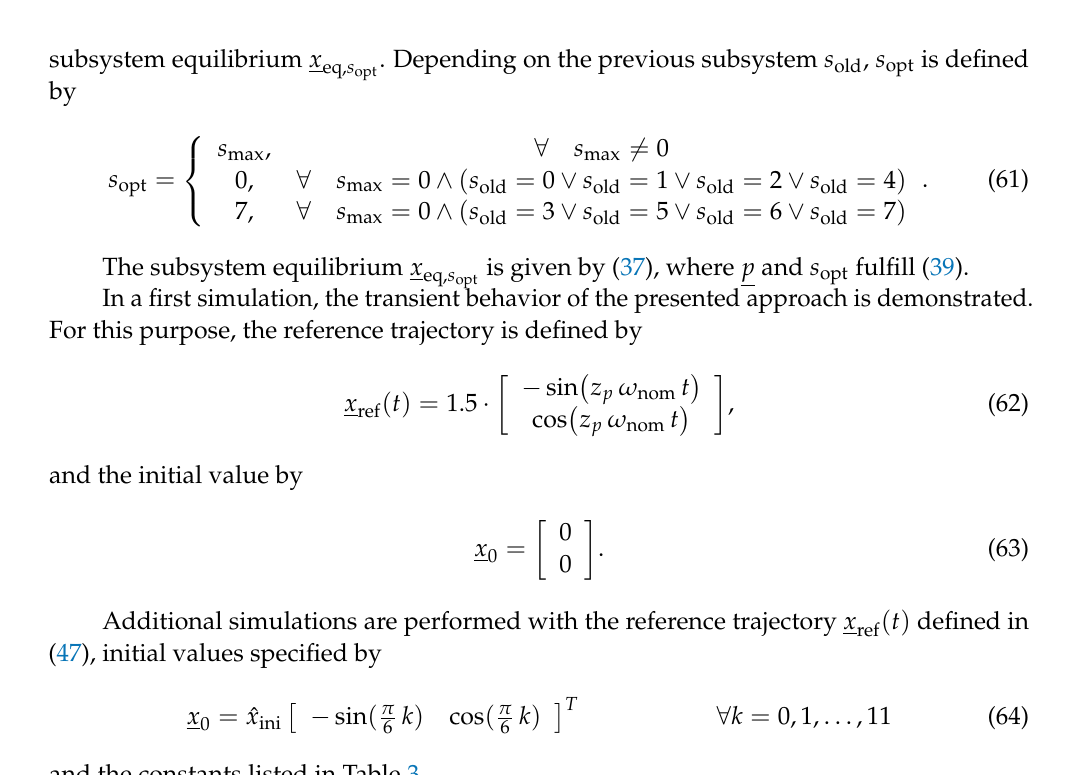
Table 3. Parameters for the reference trajectory, initial values, and hysteresis control. Constant Symbol Value Unit normalized reference speed ω (cid:48) ref normalized actual speed normalized reference amplitude ˆ x ref − initial reference angle ε ref,0 normalized initial